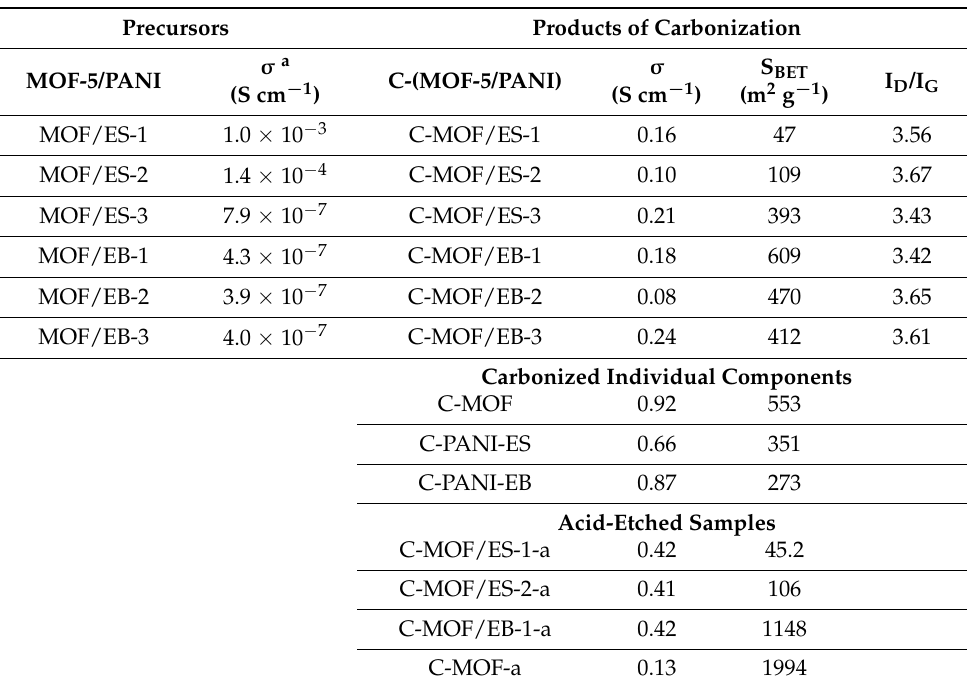
Table 4. Electrical conductivity ( σ ), specific surface area (S BET ), and the intensity ratio of Raman D and G bands (I D /I G ) of C-(MOF-5/PANI) composites. Data for S BET and σ for carbonized indi- vidual components of precursors and acid-etched samples, as well as σ of MOF-5/PANI composite precursors, are also